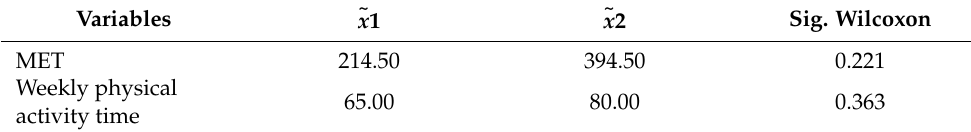
Table 5. Wilcoxon test applied to physical exercise parameters evaluated in